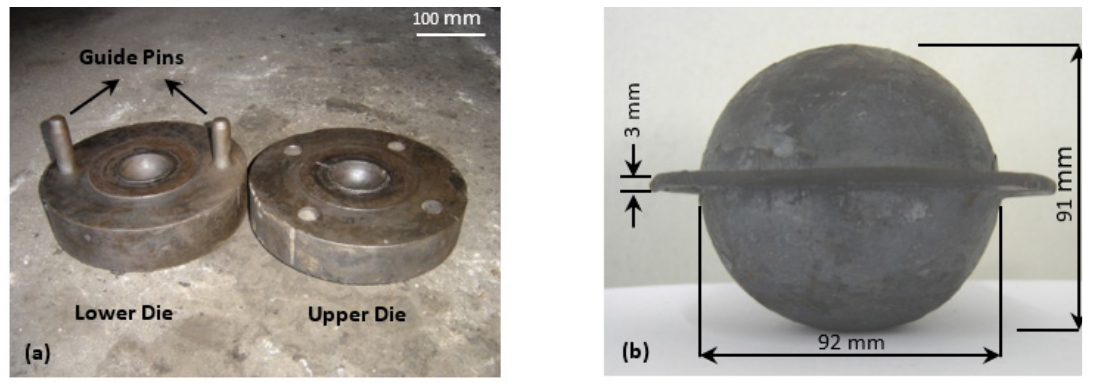
Figure 2. (a) Hot forging closed dies and (b) forged grinding ball with